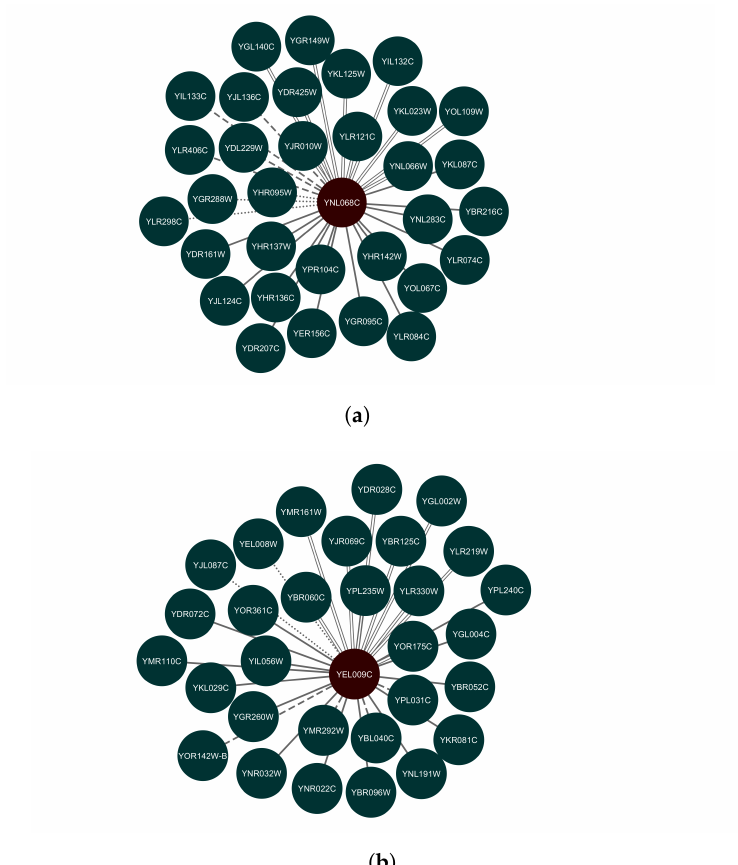
Figure 8. Two different transcription sub-networks show the TF gene and its target genes. ( a ) TF: YNL068C ; ( b ) TF: YEL009C . The shared connections that are predicted by RNA-seq and microarray, and validated by Yeastract are represented in the graph by the solid lines. The parallel lines denote new potential target genes that are the shared predictions of RNA-seq and microarray but were not found in Yeastract. Unique RNA-seq and microarray predictions are represented by dashed and dotted lines,